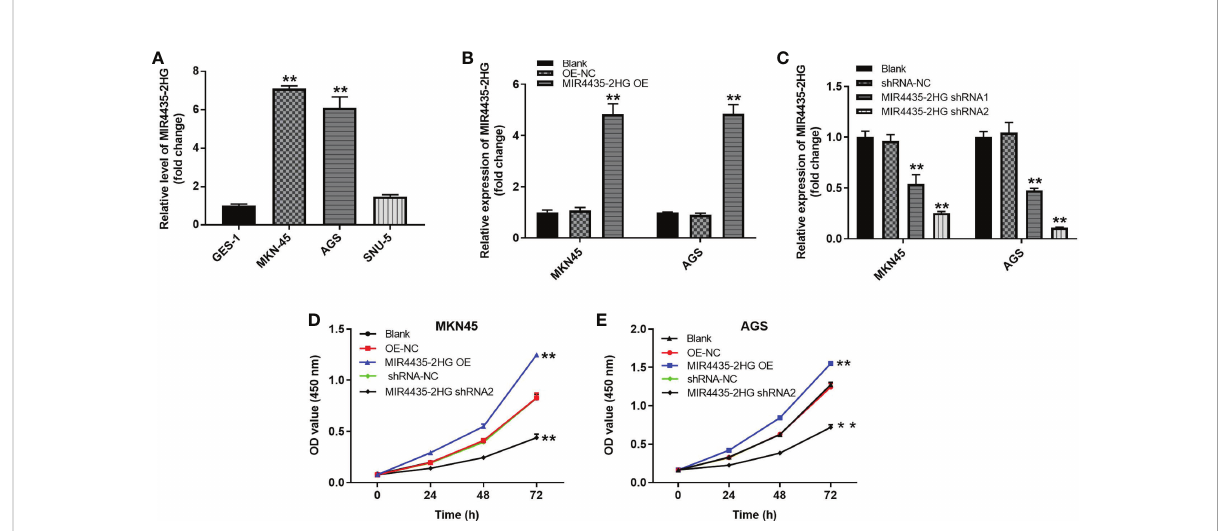
(Figure 5B). The expression of MIR4435-2HG in MKN45-Exo was signi fi cantly higher than that of GES-1-Exo (Figure 5C), whereas MIR4435-2HG overexpression or knockdown in MKN45 cell exosomes had a limited effect on exosomal protein levels (Figure 5D). MIR4435-2HG OE signi fi cantly upregulated MIR4435-2HG expression in MKN45 cells and MKN45 cell exosomes, and MIR4435-2HG shRNA2 signi fi cantly suppressed its expression (Figure 5E). Tumor-derived exosomes labeled with fl uorescent PKH26 were internalized by unstained macrophages when co-cultured with macrophages (Figure 5F). Exosomes from MKN45 cells delivered MIR4435-2HG to PMA-treated THP-1 cells (Figure 5G). Exosomes were successfully isolated from GC cells.